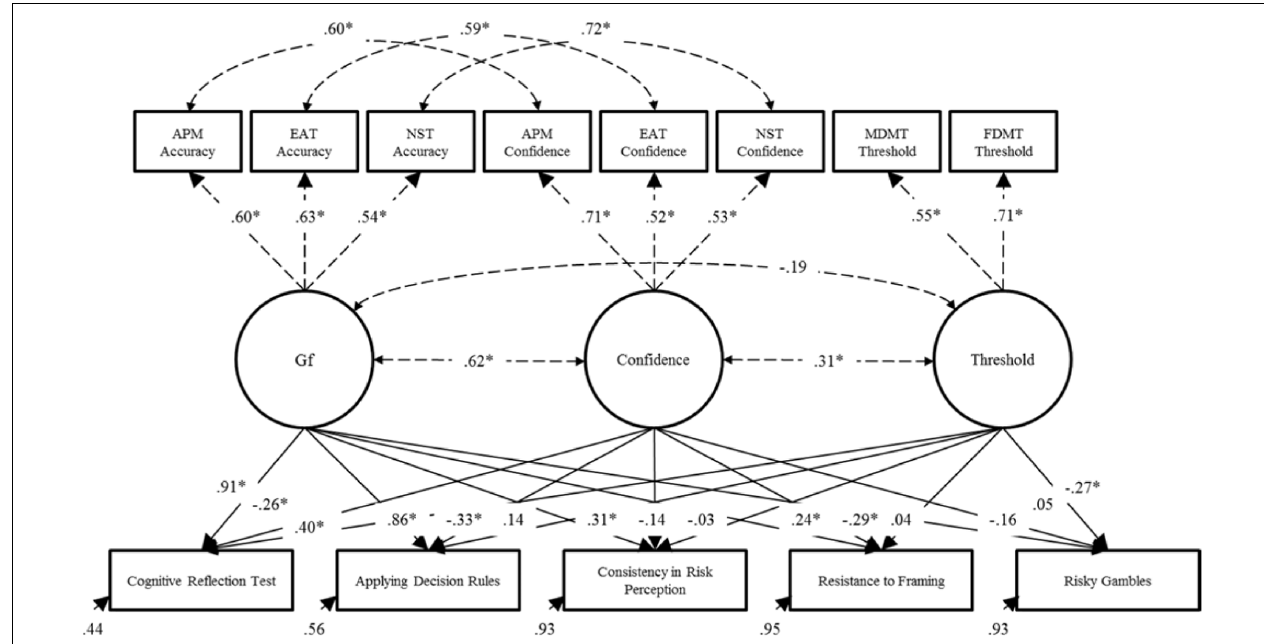
FIGURE 4 | Results of the final structural equation model described in Step 2. Dashed lines represent fixed parameters whose values and significance levels were determined in Step 1 of the model. ∗ p < 0.05. APM, Raven’s Advanced Progressive Matrices; EAT, Esoteric Analogists Test; NST, Number Series Test; MDMT, Medical Decision-Making Test; FDMT, Financial Decision-Making